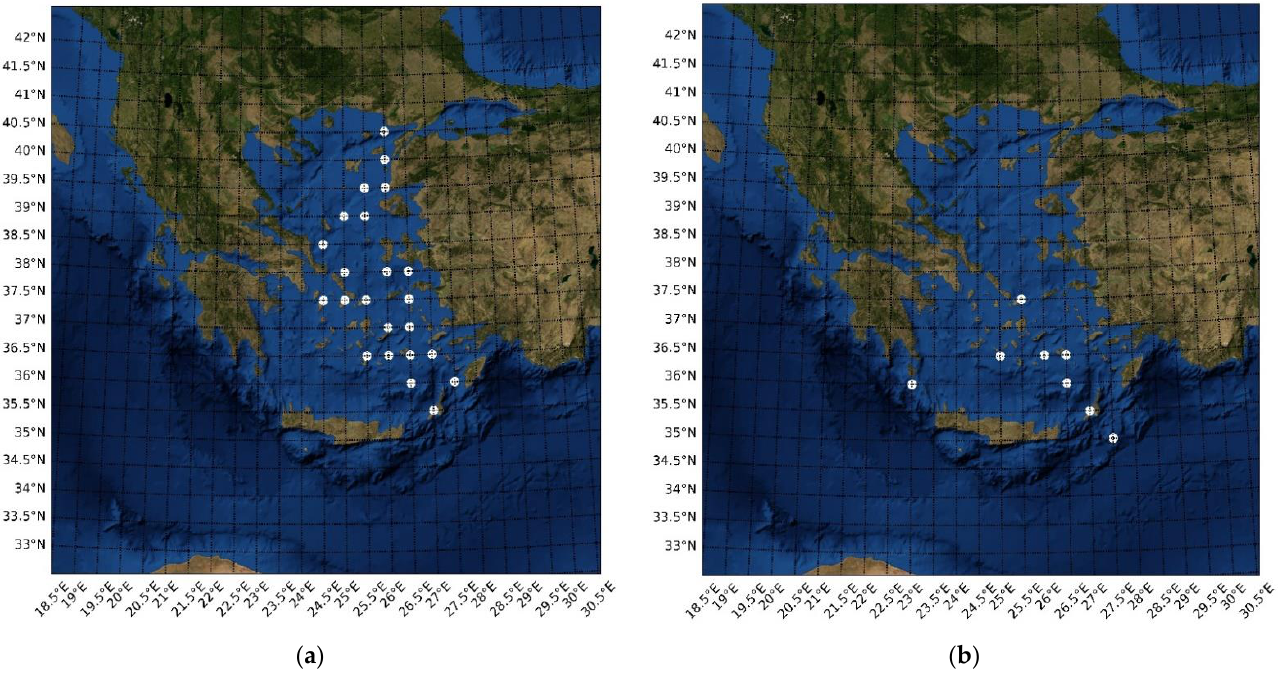
Figure 7. Locations with the highest values of wind to wave complementarity ( a ) and synergy ( b ) indices.